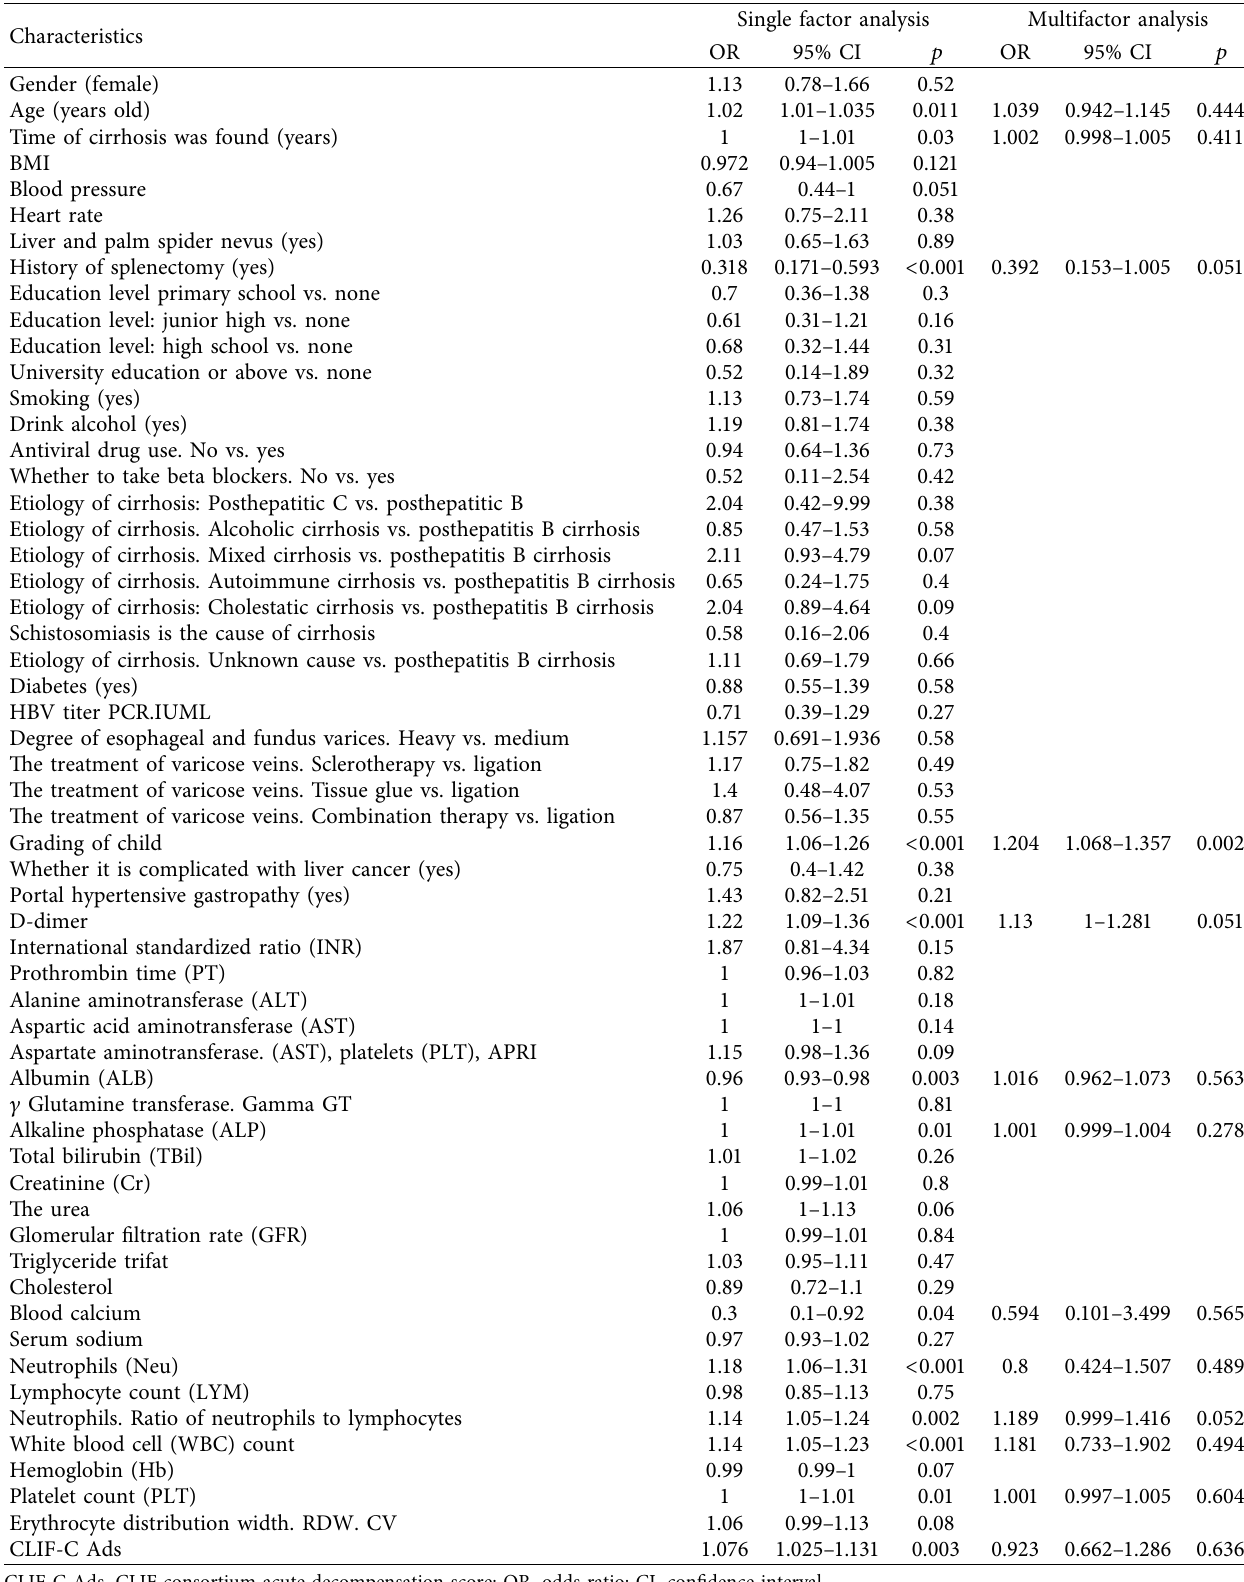
Table 2: Univariate and multivariate analyses of risk factors for patients with extra-hemorrhagic complications at admission (logistic